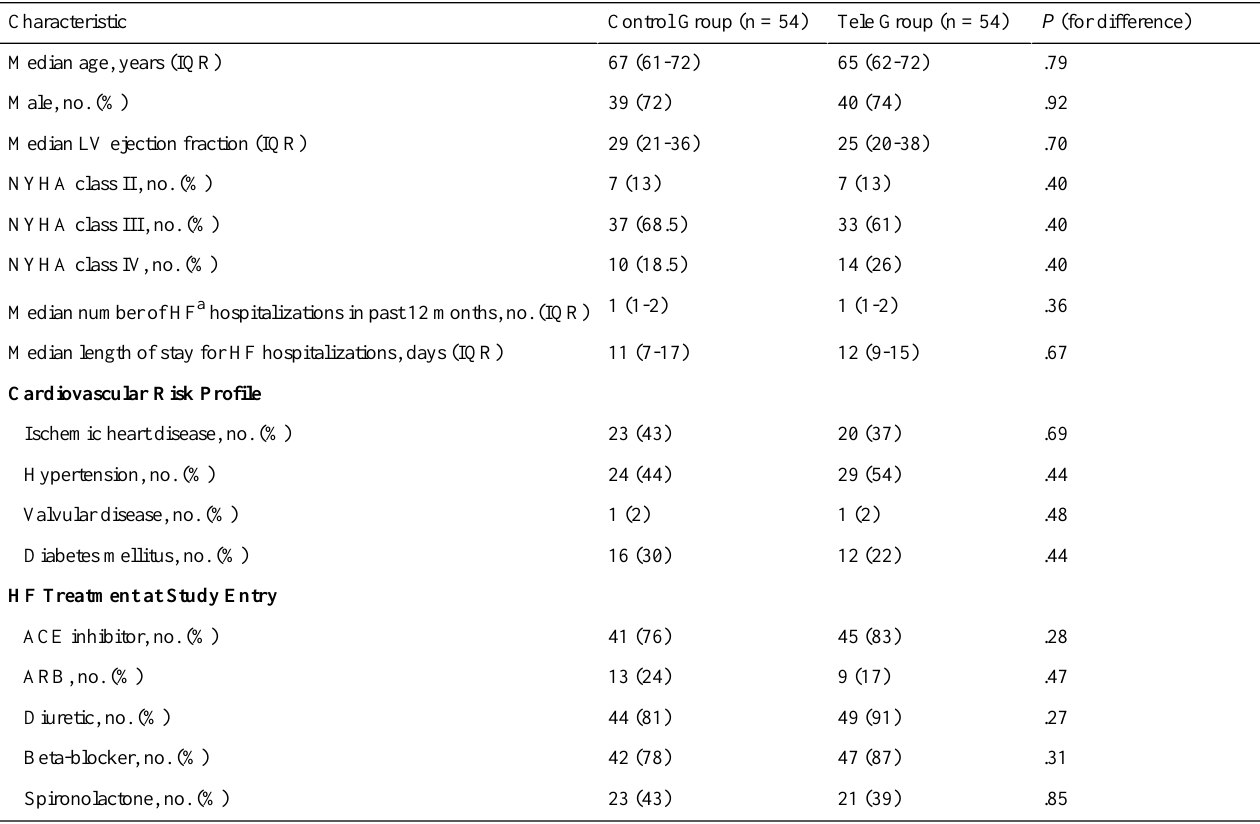
Table 1. Baseline characteristics of the MOBITEL population (per-protocol population)